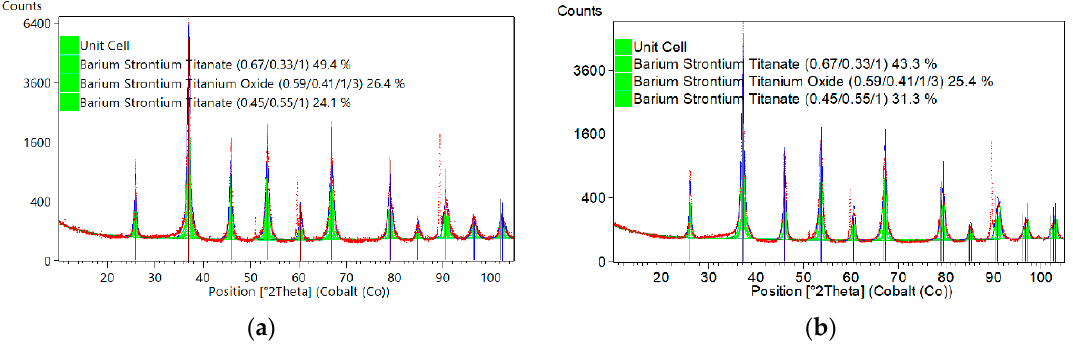
Figure 3. Results of the Rietveld analysis of X-ray diffraction patterns of the ( a ) “upgraded” ( x = 5-4-3)